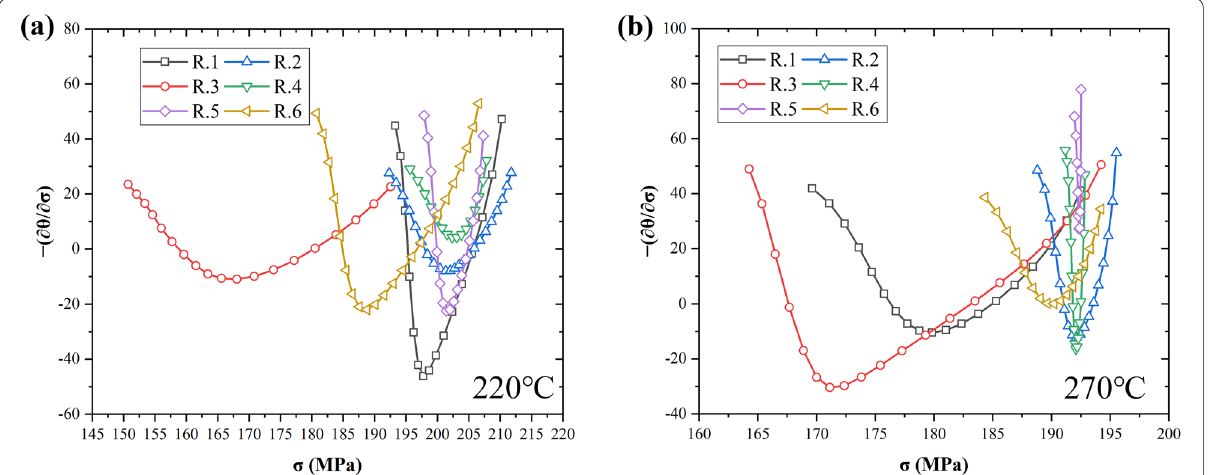
Figure 7 − (∂θ/∂σ) − σ curves of different regions at the strain rate of 15 s − 1 and various temperatures